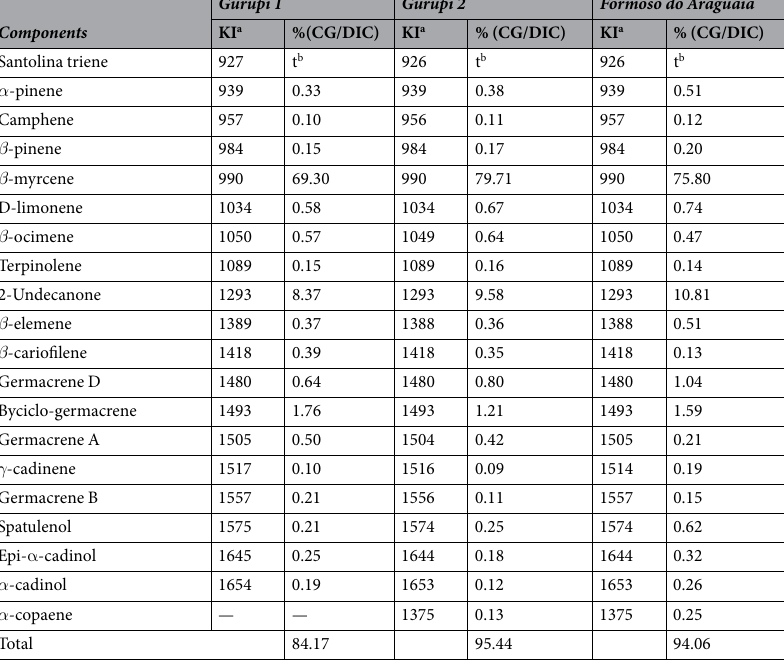
Table 1. Chemical composition of S . guianensis essentials oil samples extracted from plants from different localities of the Gurupi (i.e., Gurupi 1 and Gurupi 2) and Formoso do Araguaia counties (Tocantins